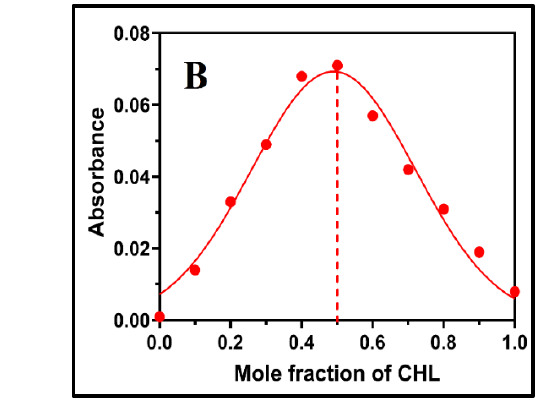
Figure 5. Job ’ s plot for complexes formation of LGN with ( A ) DDQ ( B ) CHA in MeCN (λabs for Molecules 2022 , 27 , 6320 Figure 5. Job’s plot for complexes formation of LGN with ( A ) DDQ ( B ) CHA in MeCN ( λ abs for DDQ DDQ complex (487.52 nm) and CHA complex (514 nm, C sum = 1 × 10 – 4 M). complex (487.52 nm) and CHA complex (514 nm, C sum = 1 × 10 –4 M).